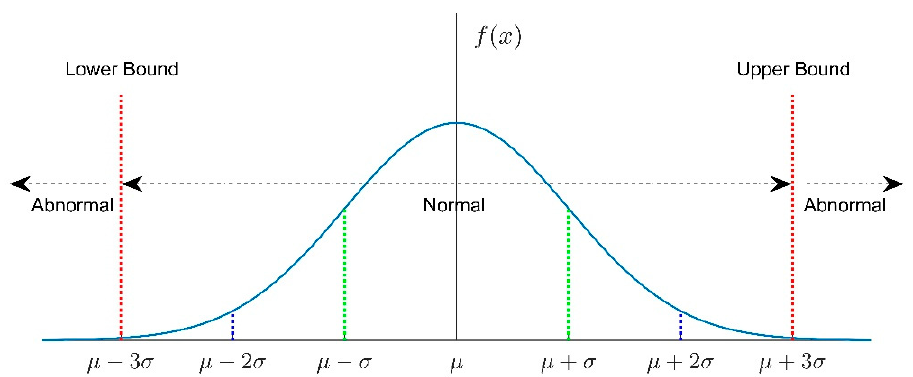
Figure 2. Probability density curve of normal distribution.